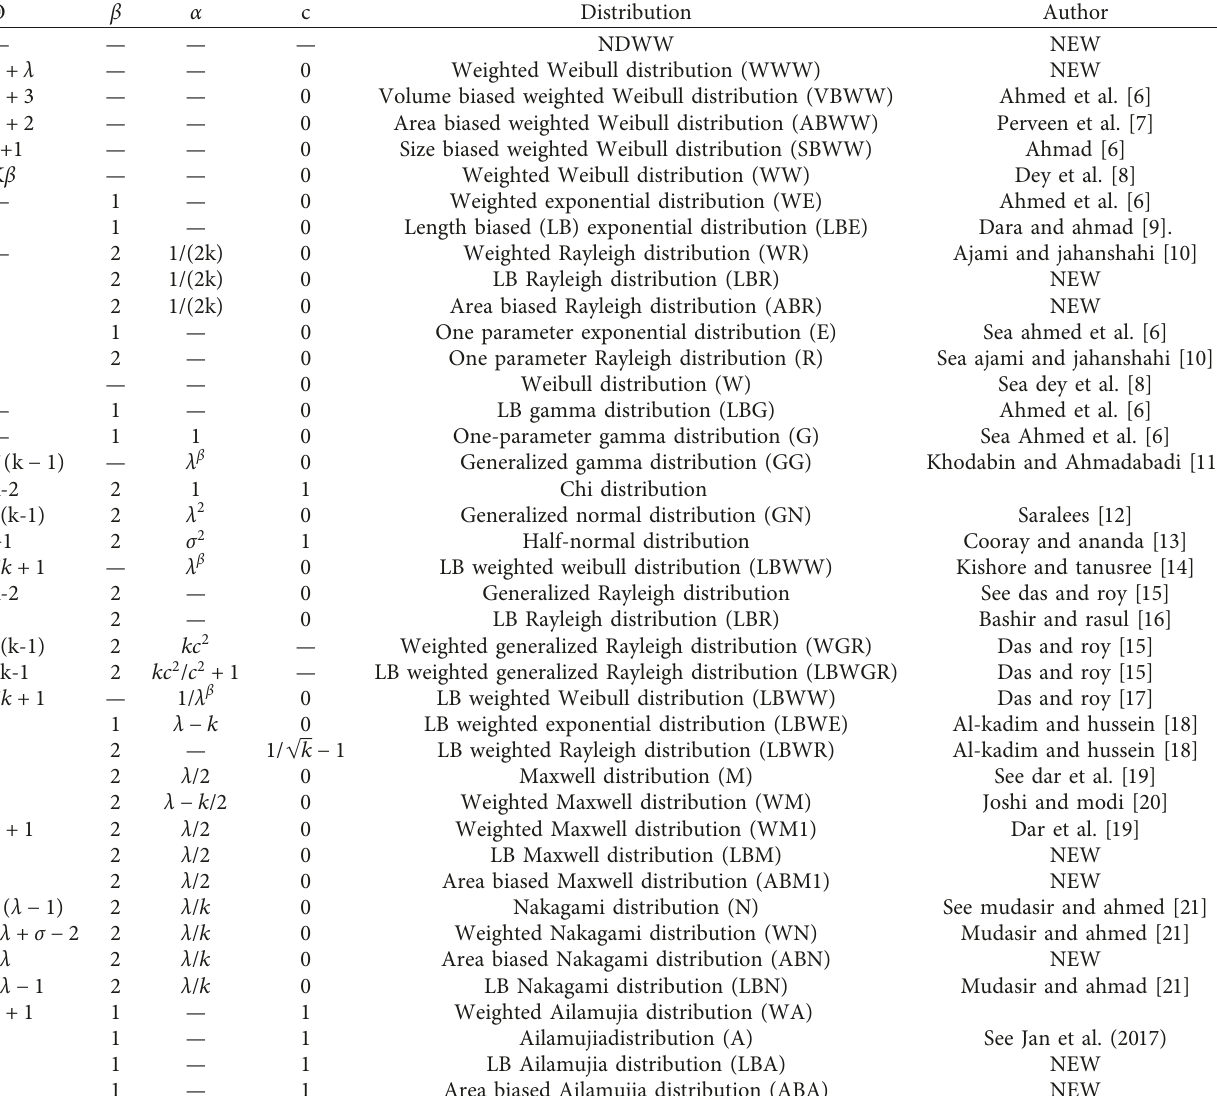
Table 2: Submodels of the NDWW